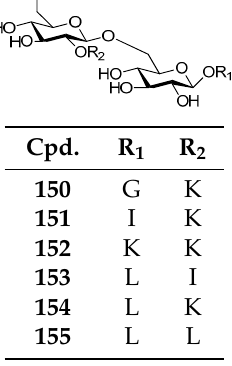
Figure 15. Structures of compounds 150 – 155 .